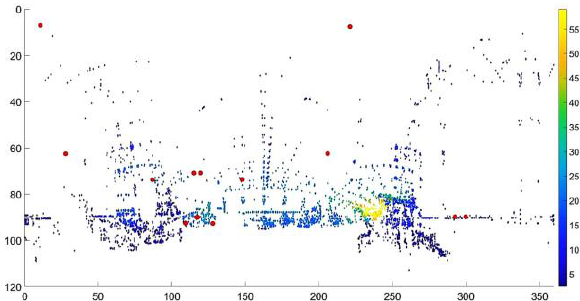
Figure 5. Distribution of the keypoints (multicolored) and targets (red) in the scanner’s FoV (x/y axes – horizontal/vertical angles in degrees, color bar – point to scanner